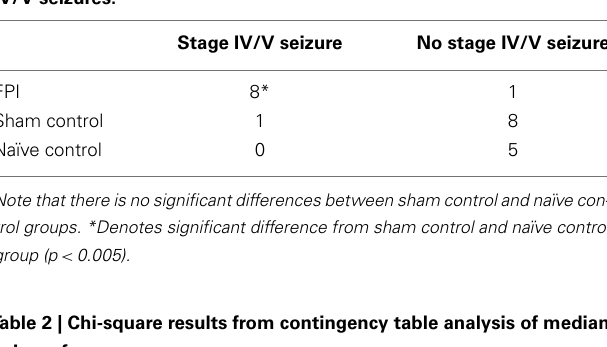
FIGURE 7 | Confocal images of trains of Iba1-labeled microglial cells in the peri-lesion area. In (A) , two separate trains of microglial cells are shown. In these trains, the microglial cells exhibit a rod-like appearance. Ziebell et al. (2012) have described a similar appearance of trains of rod-like cells in the somatosensory cortex following fluid percussion injury in rats. Similar to Ziebell et al. (2012), the rod-cells observed in the present study (both single and in trains) appeared perpendicular to the pial surface. In (B) , despite the lack of an elongated, rod-like appearance, the cells within this train appear to